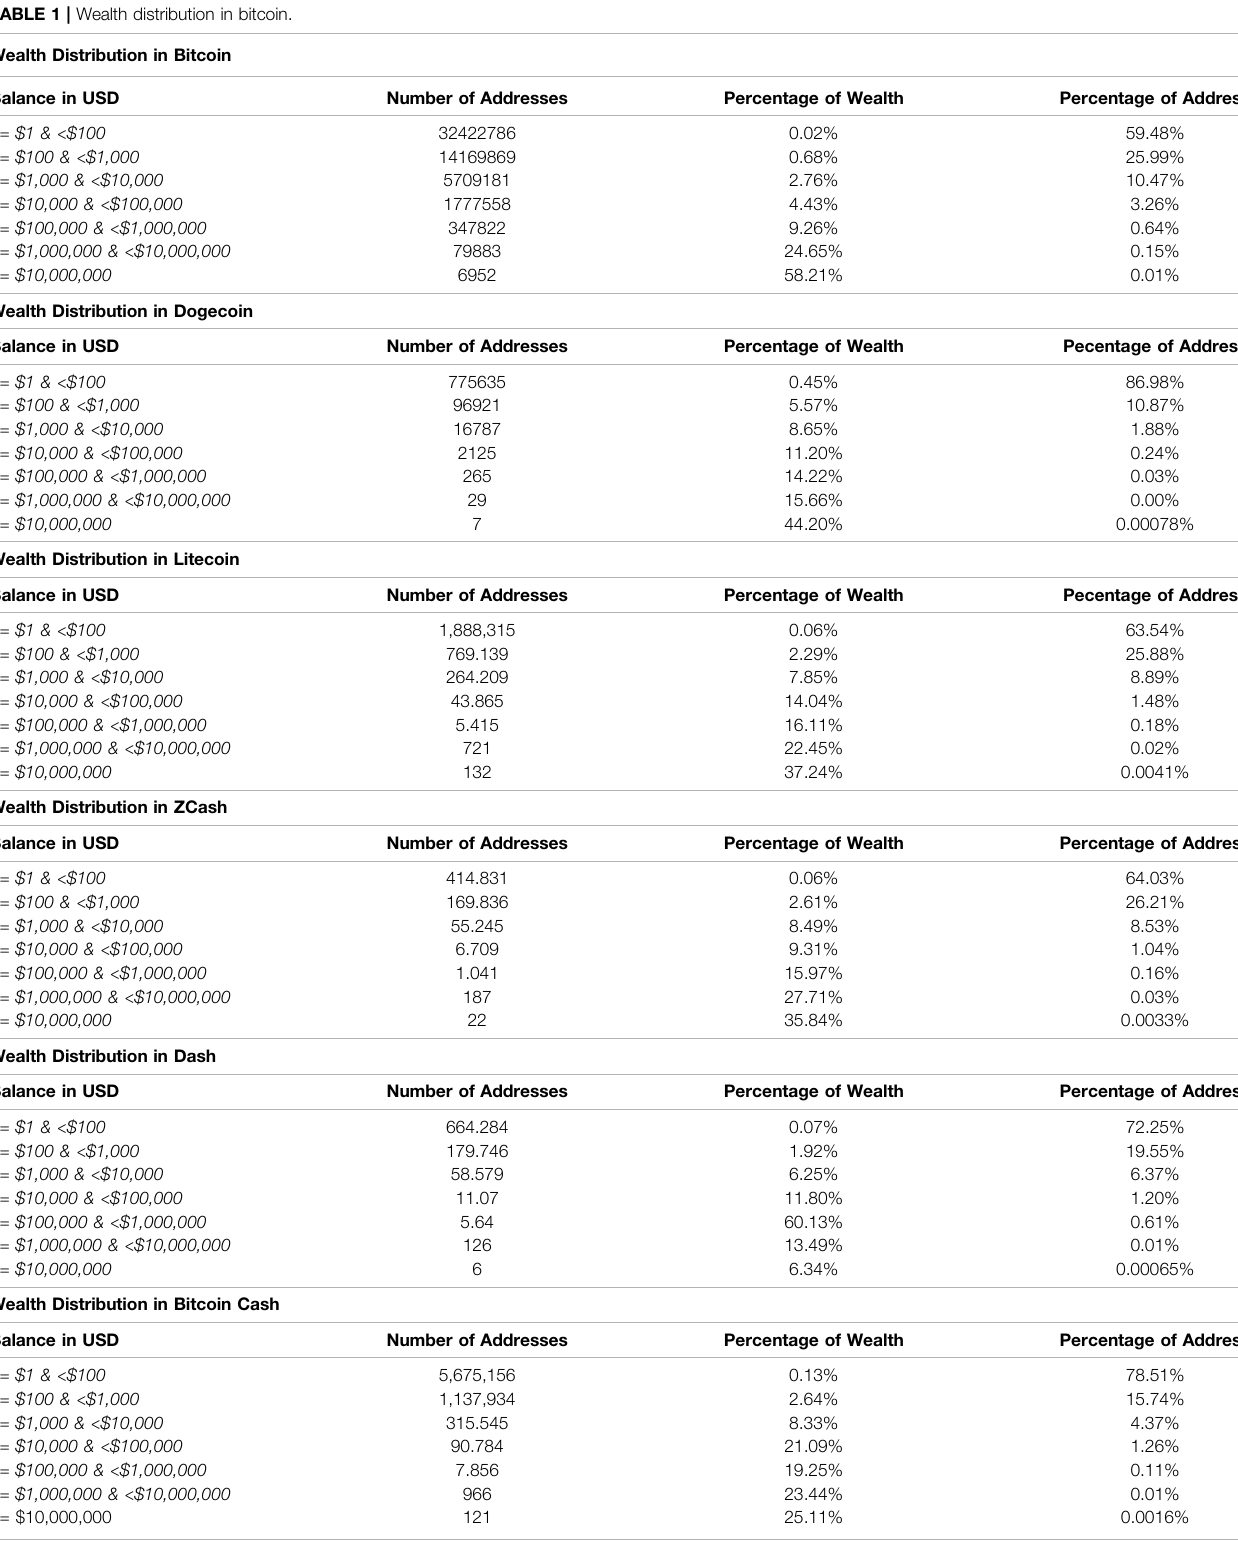
TABLE 1 | Wealth distribution in